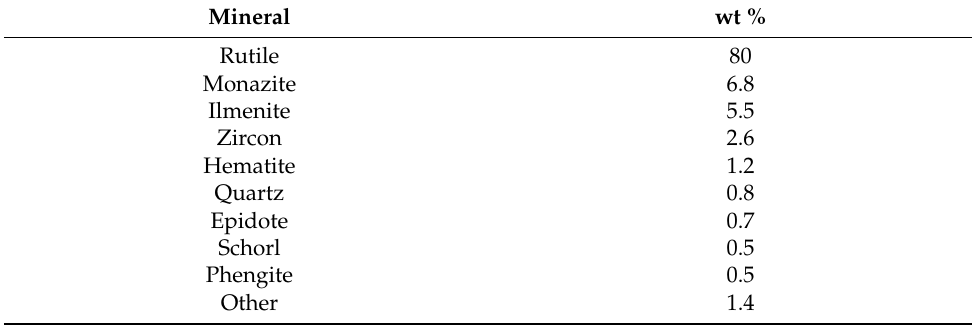
Table 3. Mineralogical composition of rutile concentrate from MS 5A.